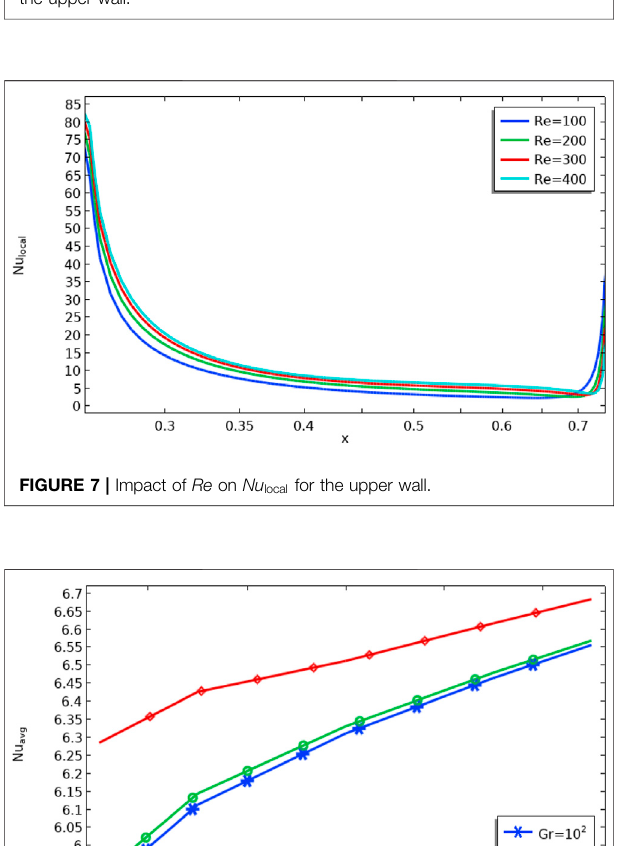
FIGURE 6 | Impact of different values of n on local Nusselt number for the upper wall.